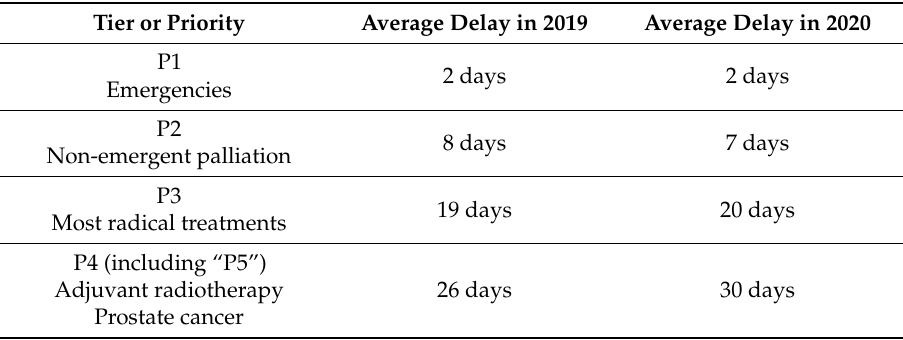
Table 4. Treatment